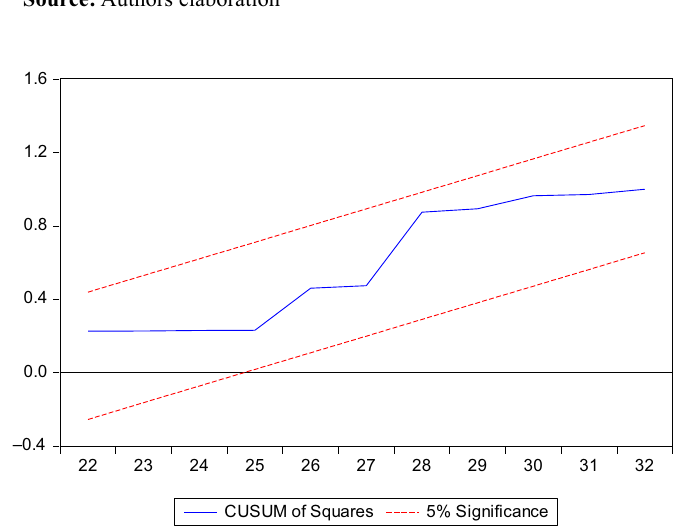
Figure 3. CUSUMQ test